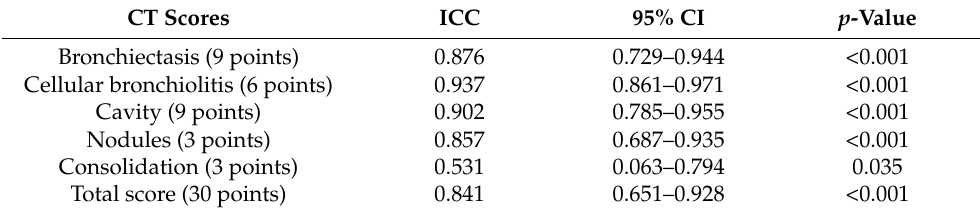
Table 3. Interobserver agreement for computed tomography (CT) scoring.